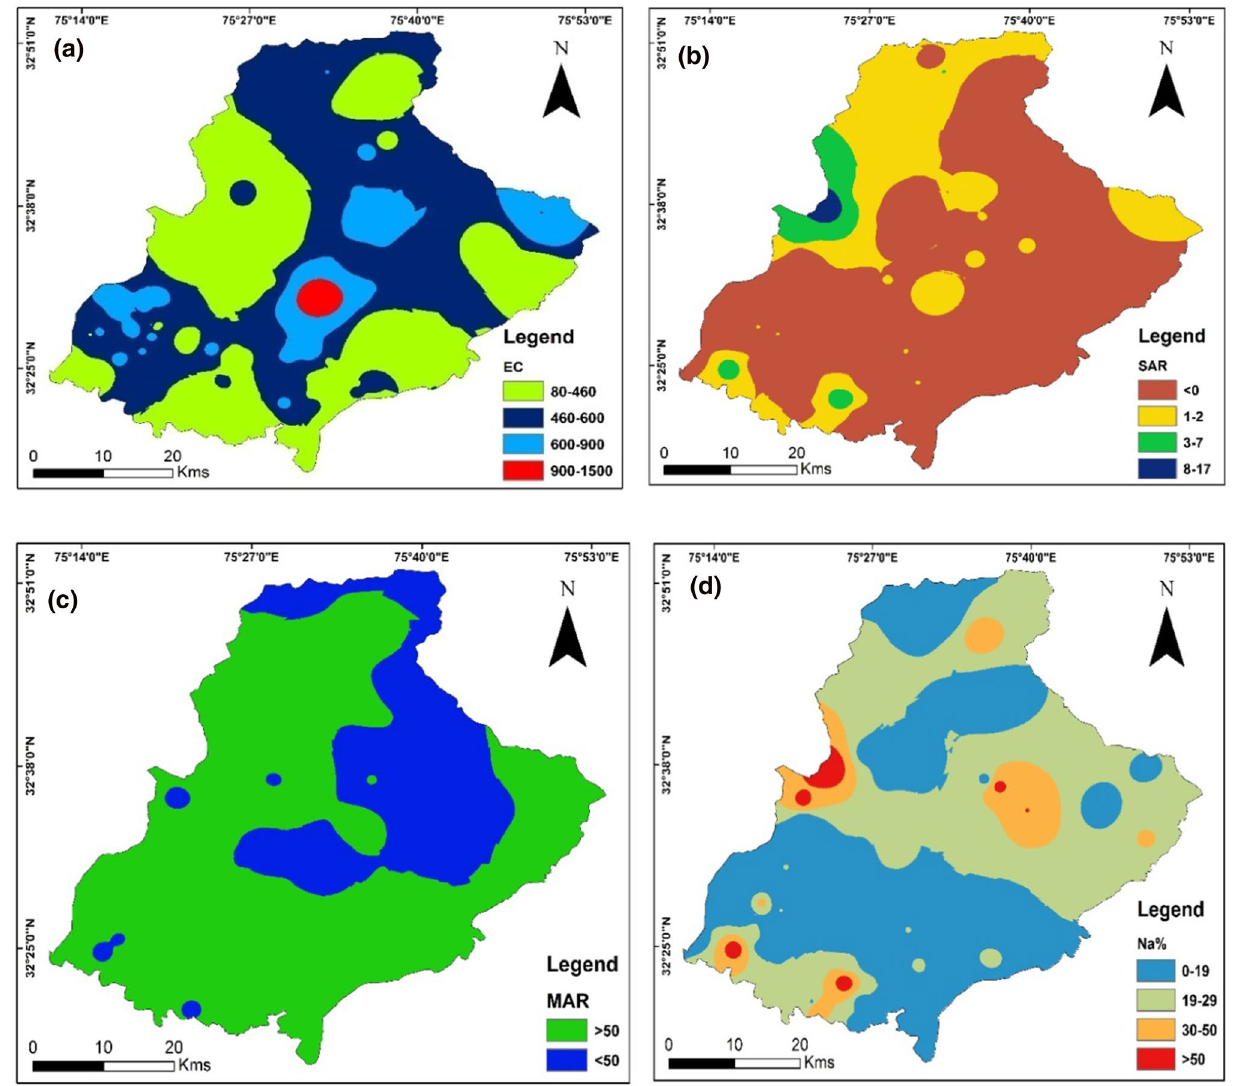
Fig. 9 Maps showing spatial distribution of a EC, b SAR, c MAR and d